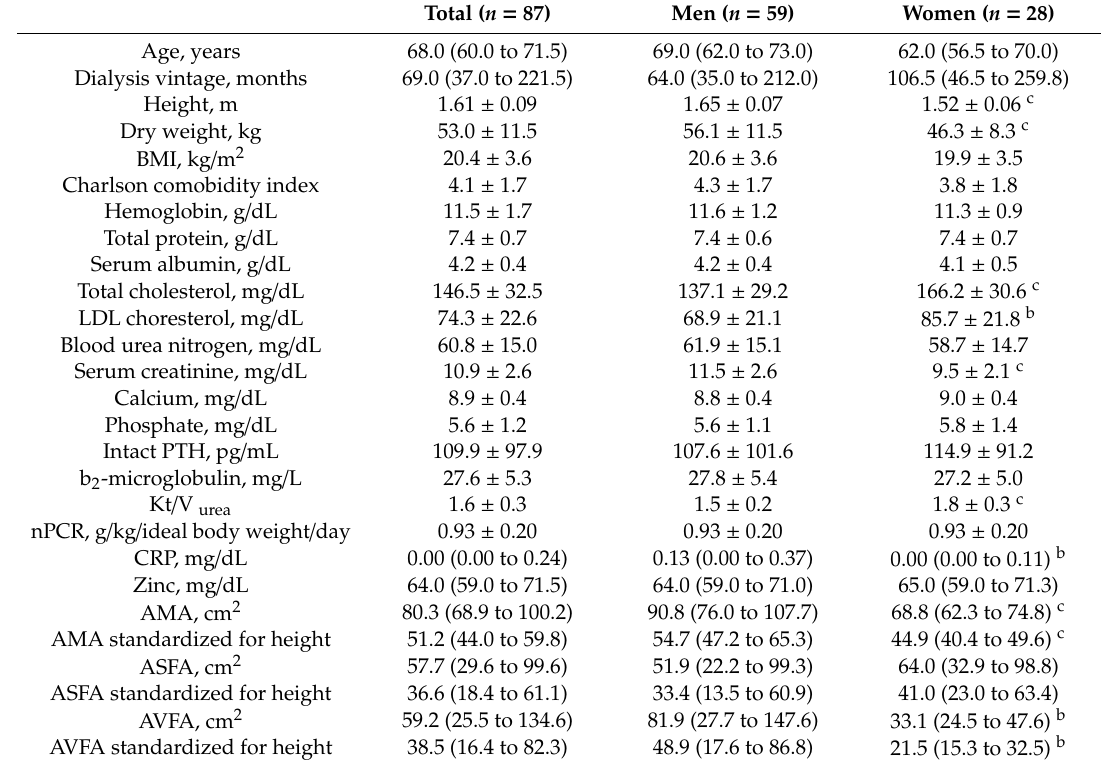
Table 1. Patient characteristics.